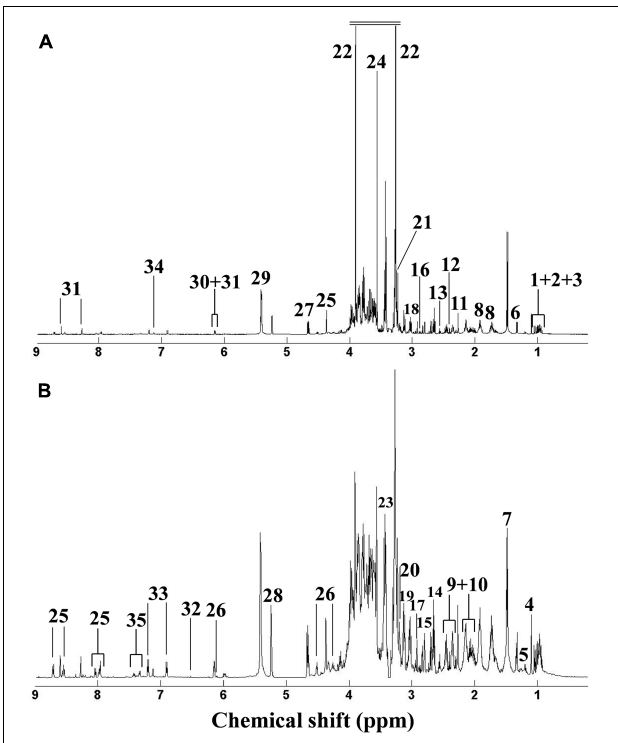
FIGURE 3 | Typical 1 H NMR spectra of serum extracts from the control group in the original. Typical 1 HNMR spectrum of metabolite extracts of Mytilus galloprovincialis from the control group. Original (A) and generalized log-transformed (B) forms. (1) isoleucine, (2) leucine, (3) valine, (4) unknown 1 (1.10 ppm), (5) 3-aminoisobutyrate, (6) threonine, (7) alanine, (8) arginine, (9) glutamate, (10) glutamine, (11) acetoacetate, (12) succinate, (13) β -alanine, histidine, and (35) phenylalanine.